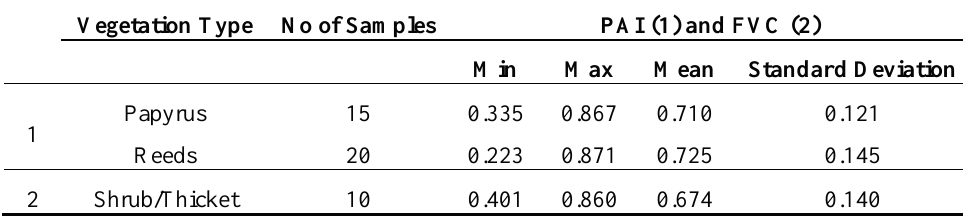
Table 2. Plant Area Index (PAI) and Fractional Vegetation Cover (FVC) measured in situ at different